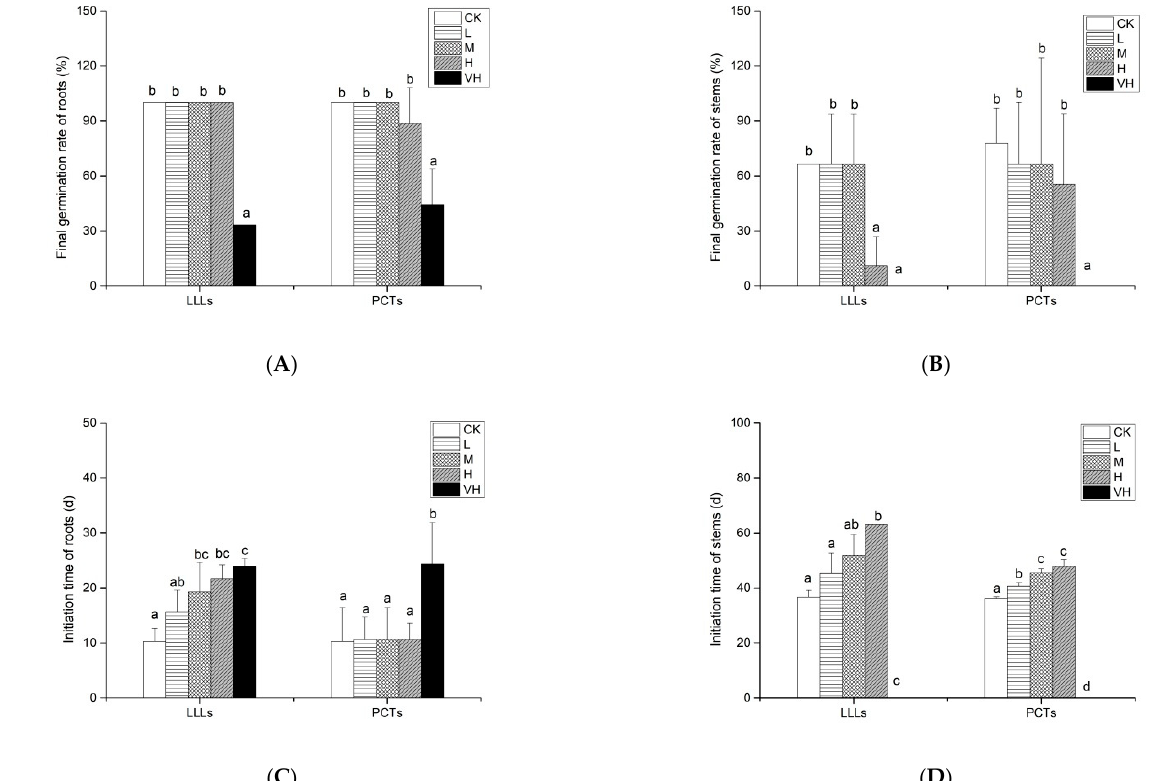
Figure 2. Effects of leaf litter leachates (LLLs, the same applies below) and purified condensed tannins (PCTs, the same applies below) from K. obovata on final germination rates and initiation times for A. corniculatum roots and stems. Young A. corniculatum propagules were exposed to 0 (CK), 2 (L), 10 (M), 20 (H), and 50 (VH) g L − 1 of leaf litter leachates and 0 (CK), 10 (L), 100 (M), 200 (H), and 600 (VH) mg L − 1 of purified condensed tannins based on 10 ppt artificial sea water for 3 months. Next, the final germination rates ( A , B ) and initiation times ( C , D ) for A. corniculatum roots and stems were evaluated and compared via the LLLs and PCTs of K. obovata treatments. Single letters (a, b, c, and d) represent significant differences among groups ( p < 0.05). Double letters ab or bc denote no significant difference to a or b (b or c). Each column (±SD) represents the mean of three individual A. corniculatum propagules. ( D ) The values for initiation time under VH concentrations of LLLs and PCTs mean infinity.